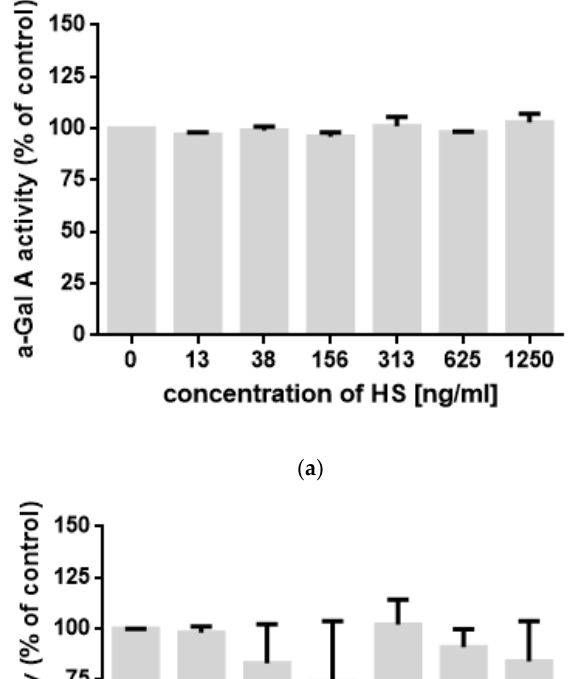
4 of 10 Figure 3. LysoGb3 concentration in MPS I patients before and on enzyme replacement therapy (ERT). **** p < 0.0001. To test if increased levels of LysoGb3 in MPS I, II, and III arise from direct impairment of the